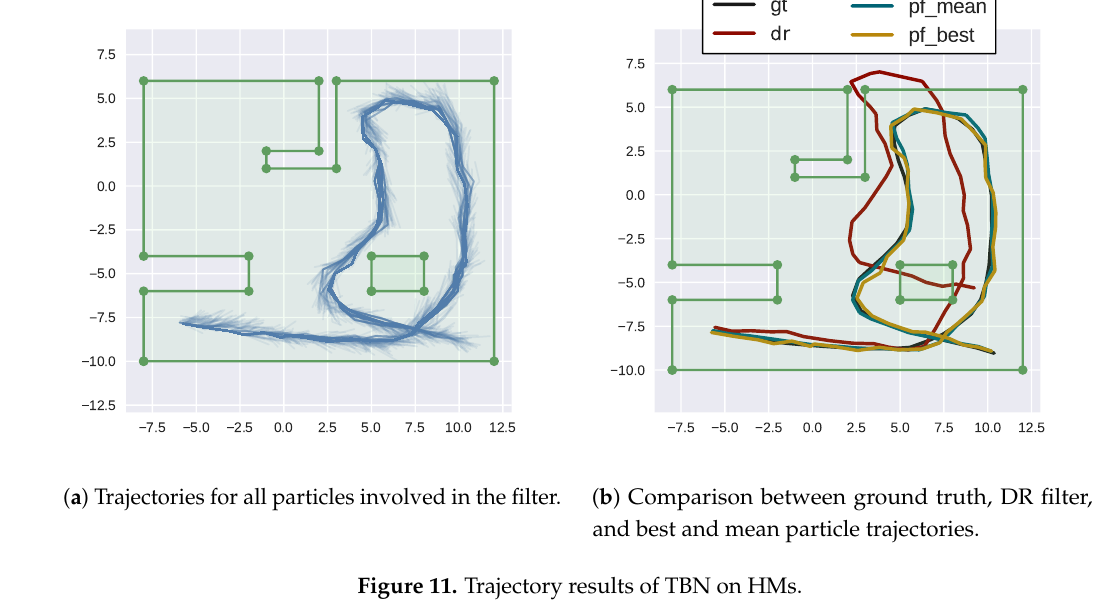
Figure 11. Trajectory results of TBN on HMs.